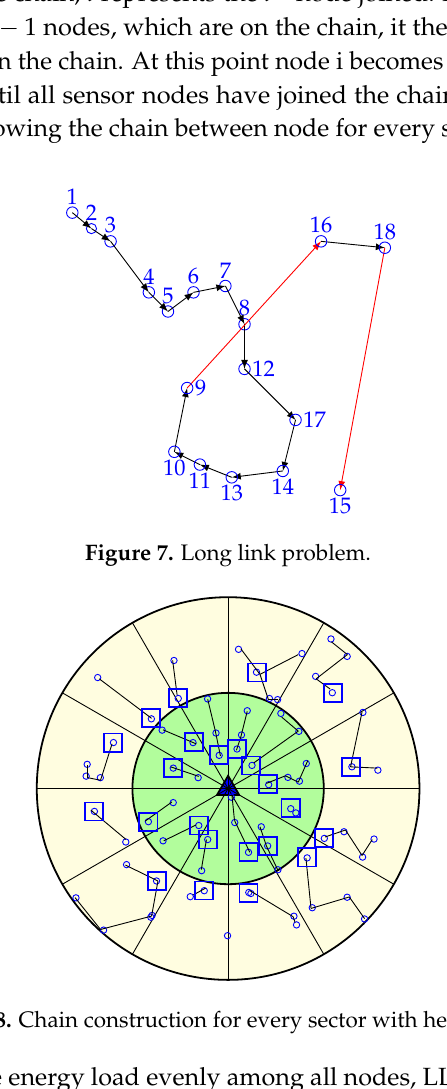
Figure 7. Long link problem.